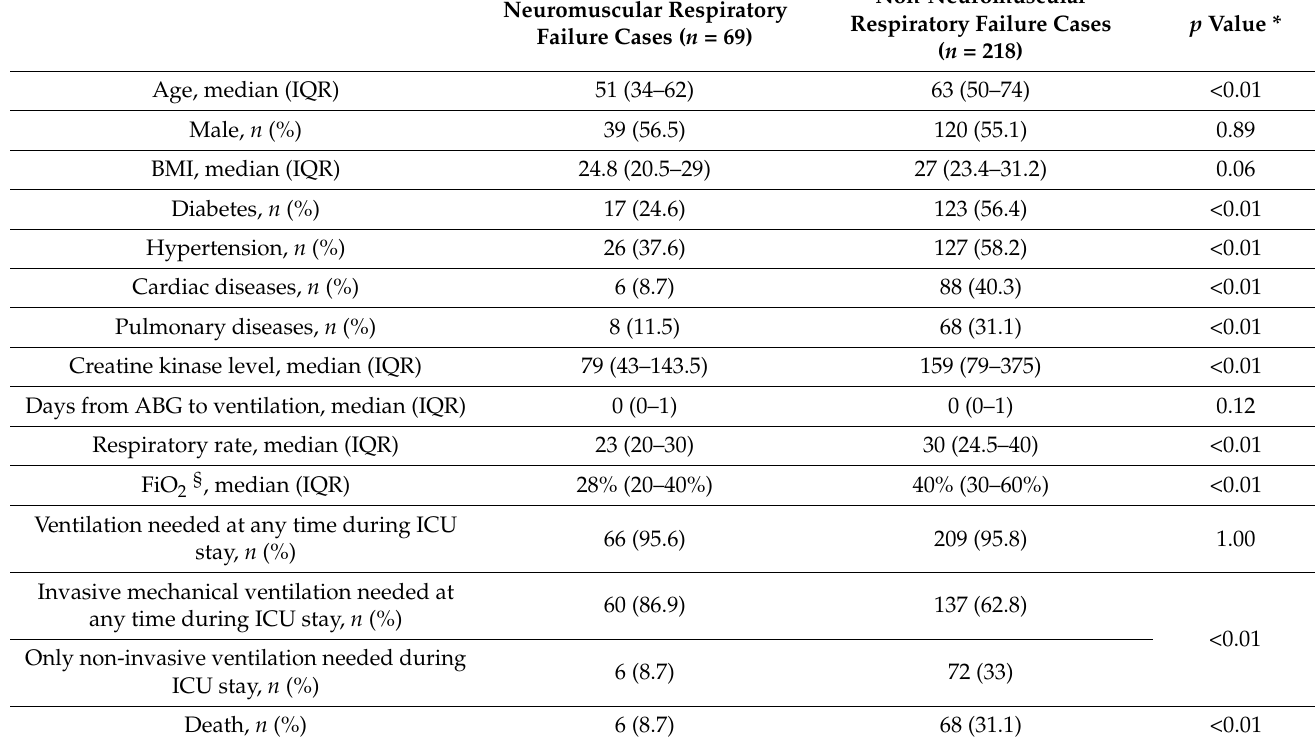
Table 1. Patient